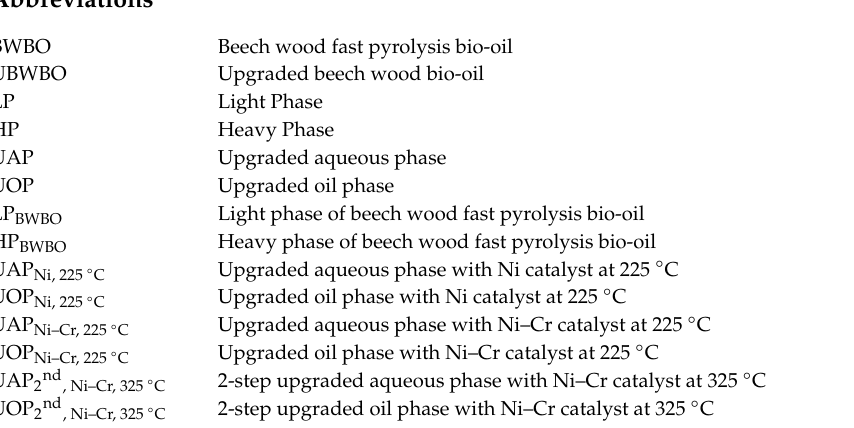
Figure S1: Autoclave used during the experiments, Figure S2: Detailed of the upgraded products after the centrifugation step, Figure S3: Upgraded products separated after centrifugation. From the left to the right: spent catalyst after filtration; upgraded aqueous phase and the two last samples in the right side are the upgraded oil, Figure S4: Products obtained after the second upgrading performed with UBWBO. From the left: upgraded aqueous phase and two bottles containing the upgraded oil, Figure S5: NH3-TPD of fresh nickel-based catalysts. Left: Ni catalyst; Right: Ni-Cr catalyst, Table S1: Characterization of upgraded beech wood fast pyrolysis bio-oils obtained with Ni / SiO2, Table S2: Comparison of reactions conducted with Ni catalyst at 225 ◦ C for 2 h and 4 h, wet basis, Table S3: Elemental analysis and physicochemical properties of upgraded aqueous phase upgraded with Ni, Ni-Cr and Ru / C catalysts, Table S4: Single compounds identified by GC-MS / FID in the upgraded oils and